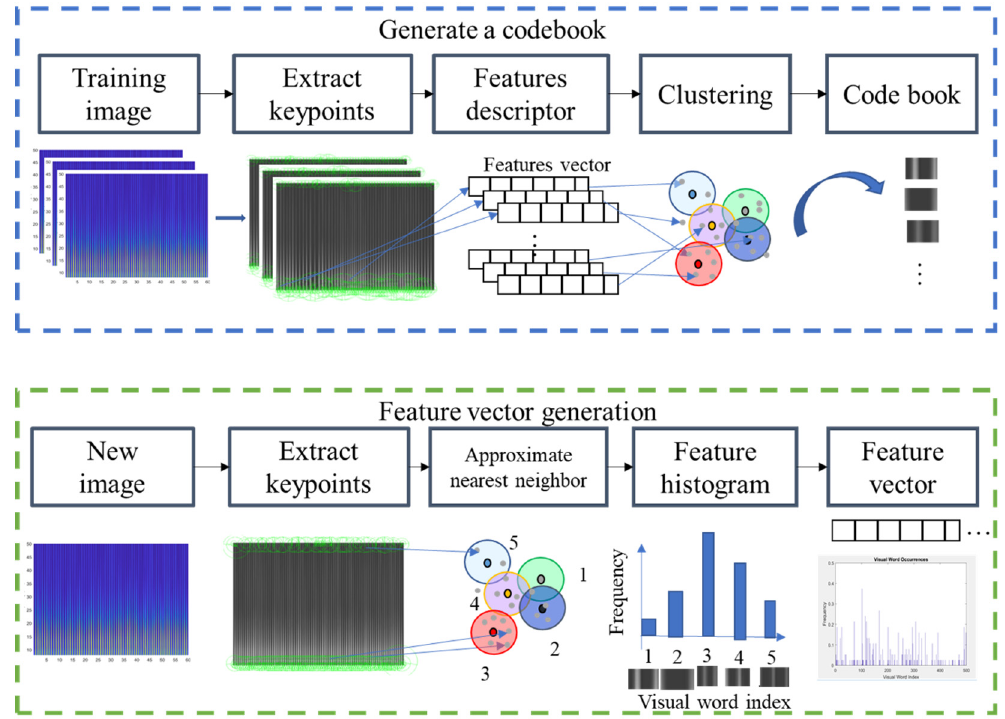
Figure 4. Codebook and feature vector generation for the proposed bag-of-features method.